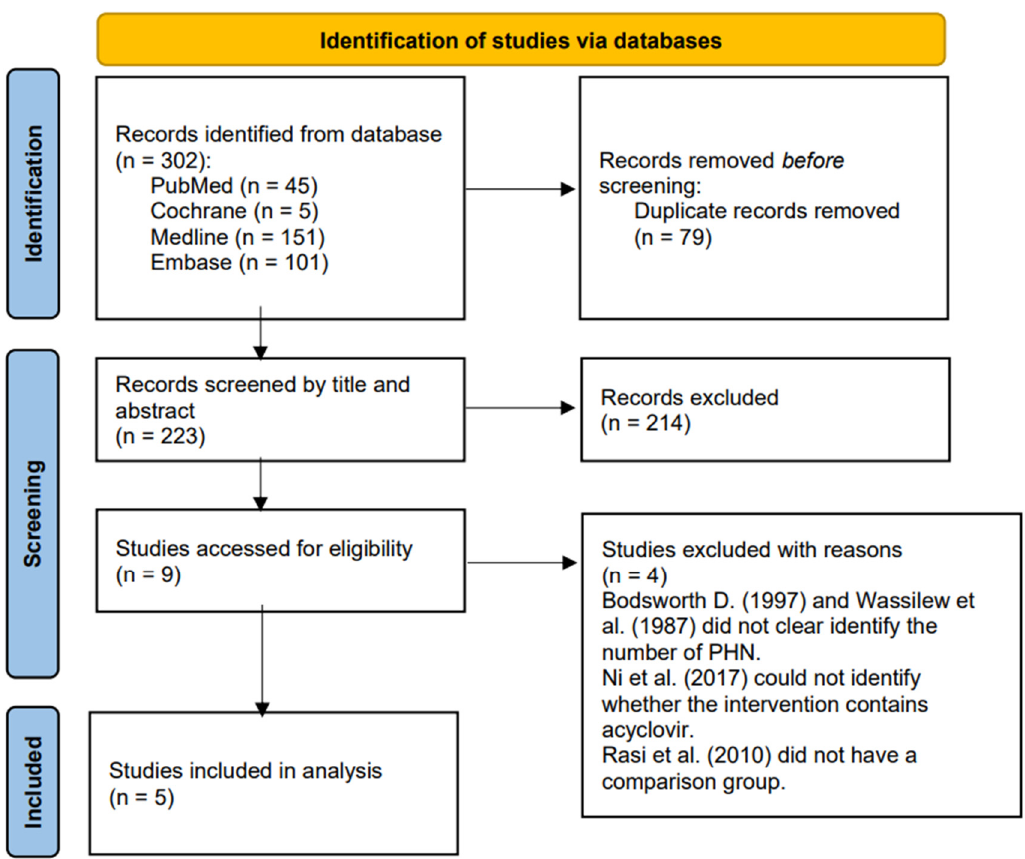
Figure 1. PRISMA 2020 flow diagram for the identification of relevant studies.